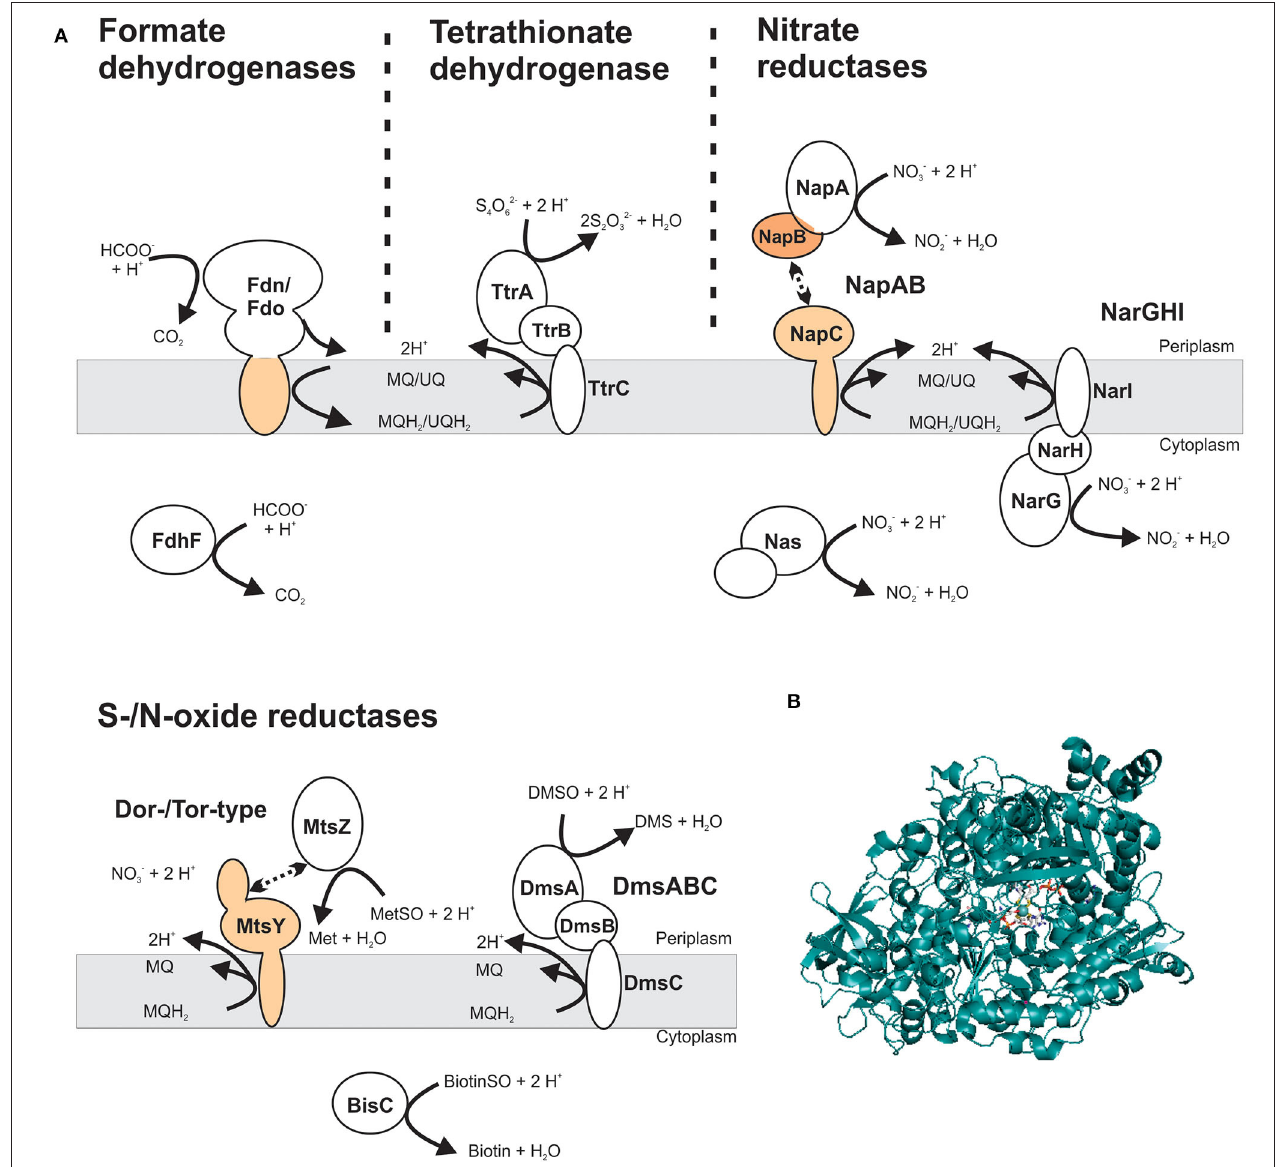
FIGURE 5 | Structure and subcellular location of DMSOR family enzyme that support virulence in different bacterial pathogens. (A) Schematic representation of enzyme structures, showing both membrane-bound and soluble Mo-enzyme complexes. The most common structure for DMSOR family enzymes is heterotrimeric ( αβγ ), consisting of a Mo-containing subunit; an iron-sulfur protein and a membrane-integral subunit that may or may not bind hemes. Additionally, some enzymes that consist of a soluble Mo-binding subunit or a protein complex that includes the catalytic subunit that interacts transiently with a heme-binding membrane-integral cytochrome. Gray – Mo-binding subunit; orange – heme-binding subunits. MQ – menaquinone; MQH 2 – menaquinol; UQ – ubiquinone; UQH 2 – ubiquinol. (B) Crystal structure of NarG, the catalytic subunit of the respiratory nitrate reductase from Escherichia coli (PDB: 1R27) with the Mo-bisPGD cofactor shown in stick form. Colors: white – carbon, blue – nitrogen, orange – phosphor, red – oxygen, yellow – sulfur, light teal– molybdenum, protein backbone – teal.